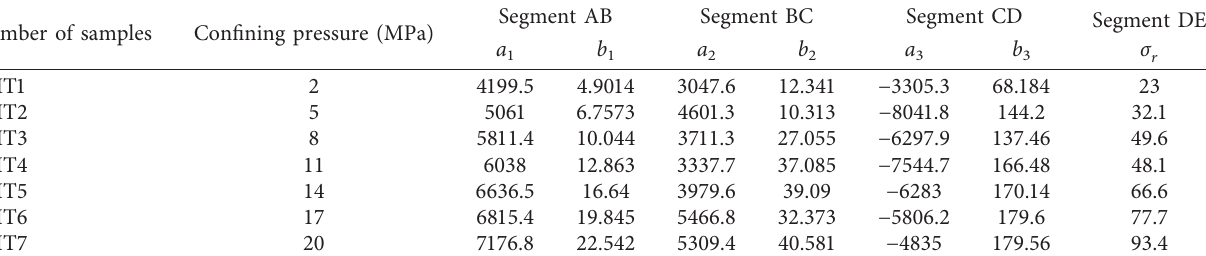
Table 3: Calculation results of fitted